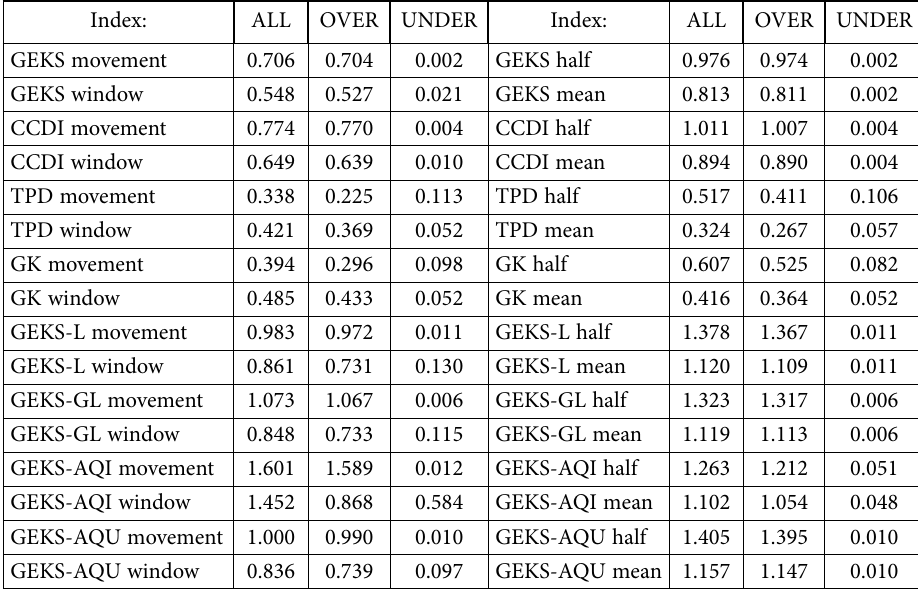
Table 7. Mean absolute distances between considered splice indices and the corresponding target full- window index for coffee products (p.p)